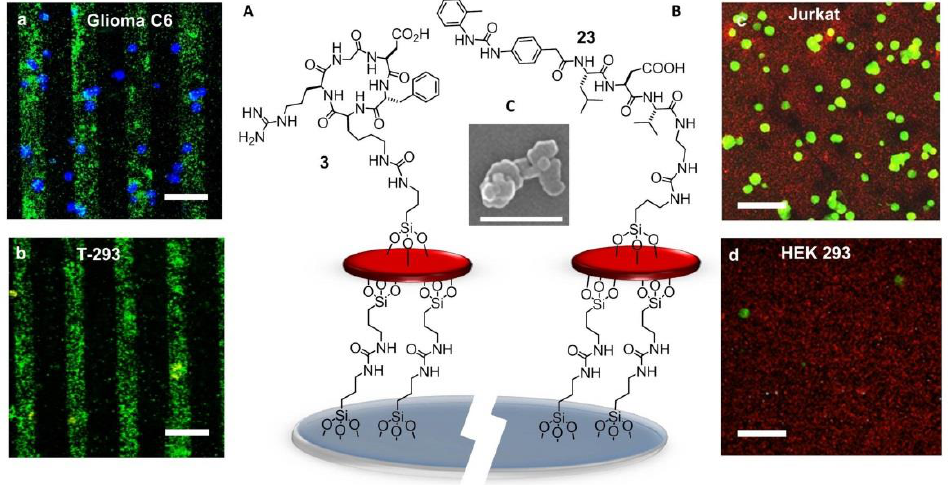
Figure 15. ( A ) Sketch of c[RGDfK]-zeolite SAM bound onto a glass substrate. Confocal images of the patterned c[RGDfK]-SAM after 30 min incubation with ( a ) glioma C6 and ( b ) primary endothelial cells T-293 (scale bar = 100 μm). ( B ) Sketch of urea-LDV-zeolite SAM. Confocal microscopy images of urea-LDV-SAM visualized after 15 min incubation with ( c ) Jurkat cells and ( d ) HEK-293 cells (scale bar = 50 μm). ( C ) SEM image of zeolite L crystals (white bar = 500 nm).